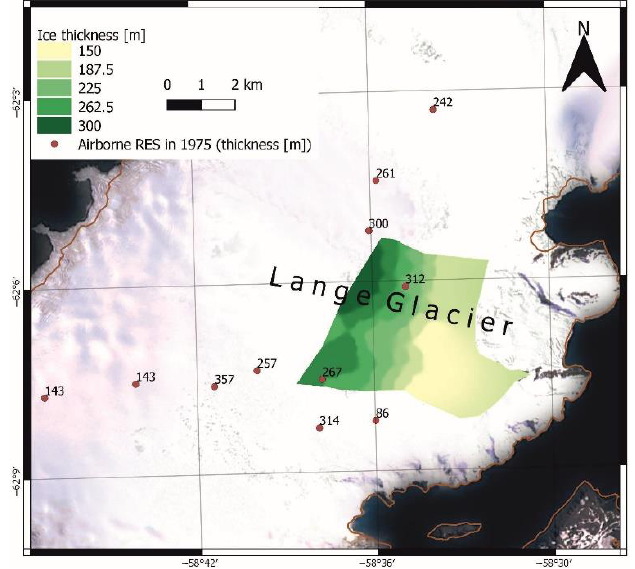
Figure 15. Ice thickness of Lange Glacier. The data used to construct the figure were obtained with permission from Simões and Bremer [56] published in 1995 and interpolated based on the data reused with permission from Macheret and Moskalevsky [73] published by Cambridge University Press, 1999.